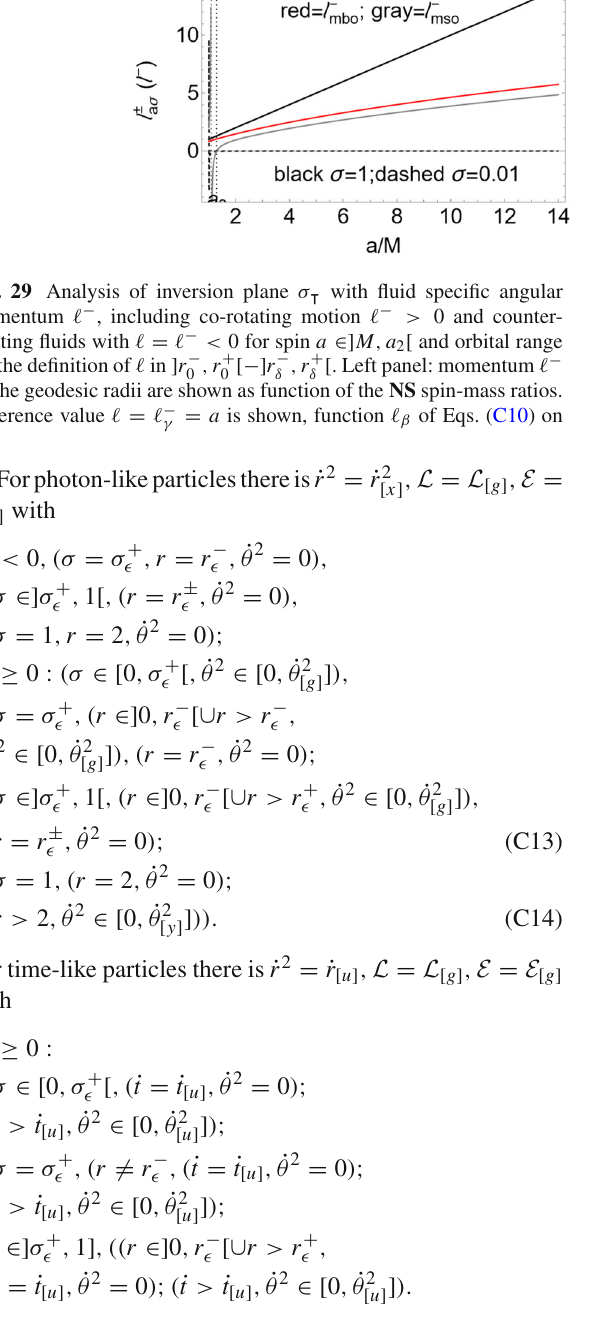
Fig. 28 Fluid specific angular momentum (cid:6) ± a σ of Eq. (C7) as function the NS spin – mass ratio a / M for different planes σ ≡ sin 2 θ . Right panel is a close-up view of the left panel. Spins { a 0 , a 1 , a 2 } are defined in